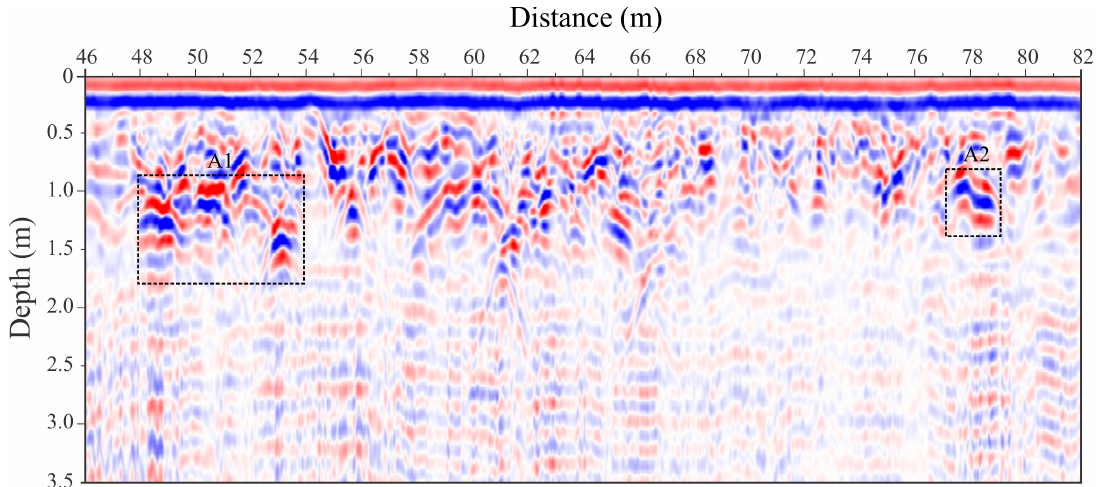
Figure 9. Segment of the GPR 2 profile of 200 MHz acquired in area 2. The black dashed rectangles highlight anomalies A1 and A2.